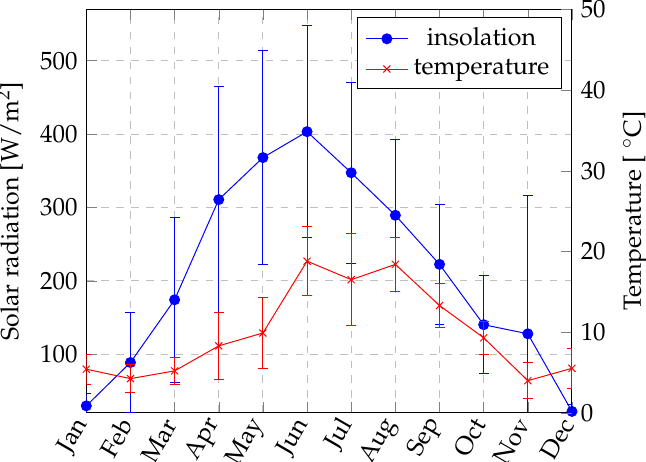
Figure 3. Average insolation and ambient temperature for the considered